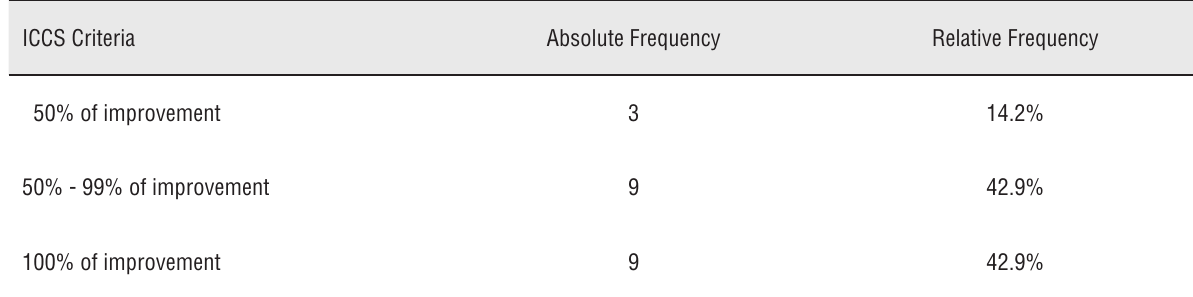
Table 2 - Improvement of Enuresis based on the International Children’s Continence Society (ICCS) criteria. ICCS